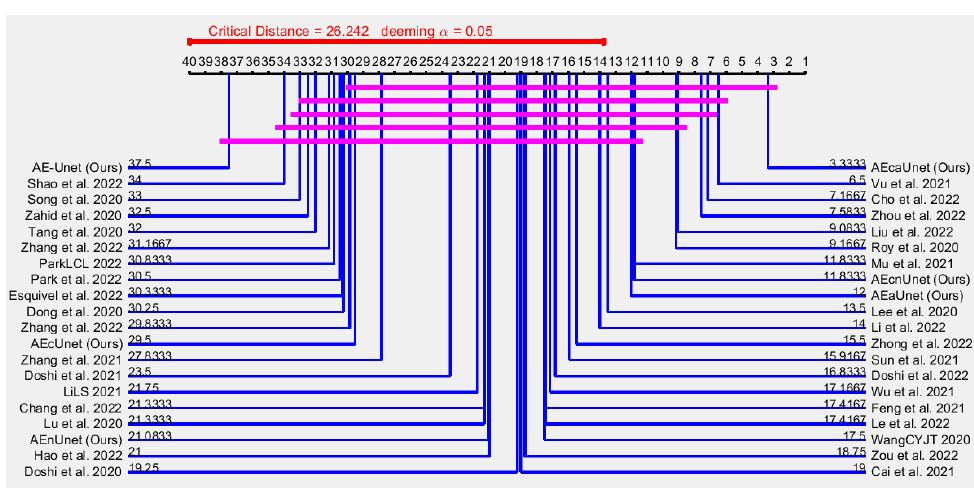
Figure 18. Nemenyi [141] post hoc critical distance diagram for α = 0.05 using fAUC scores in Table 7 for G 2